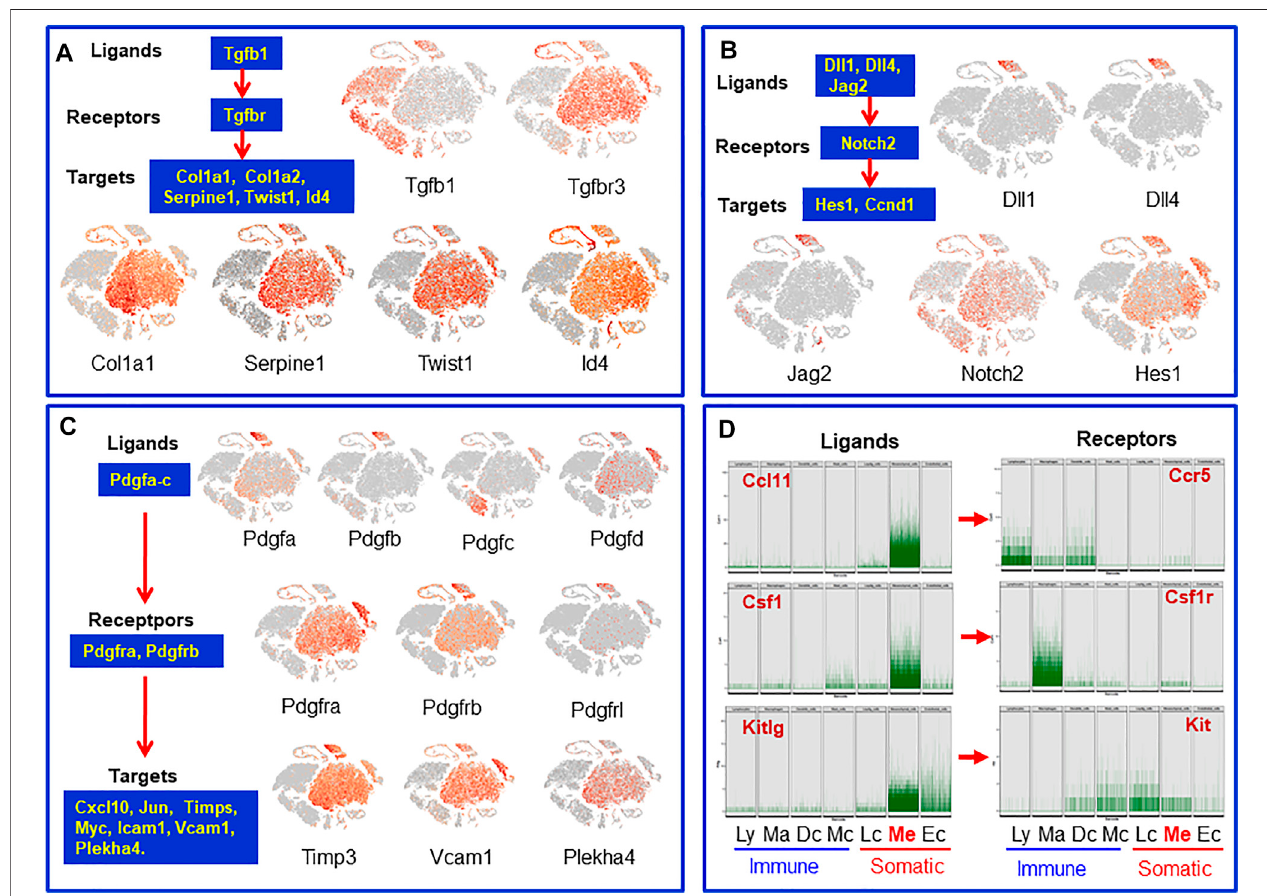
FIGURE 7 | Cells and their paracrine regulatory factors that have potential to target mesenchymal SLCs or be targeted by factors from mesenchymal SLCs. (A) Tgfb family. (B) Notch family. (C) Pdgf family. (D) Transcript levels of individual cells of the mesenchymal cluster whose protein receptor genes were expressed by neighbor interstitial cells. Ly, lymphocytes; Ma: macrophages; Dc, dendritic cells; Mc, mast cells; Lc, Leydig cells; Me, mesenchymal cells; Ec, endothelial cells.